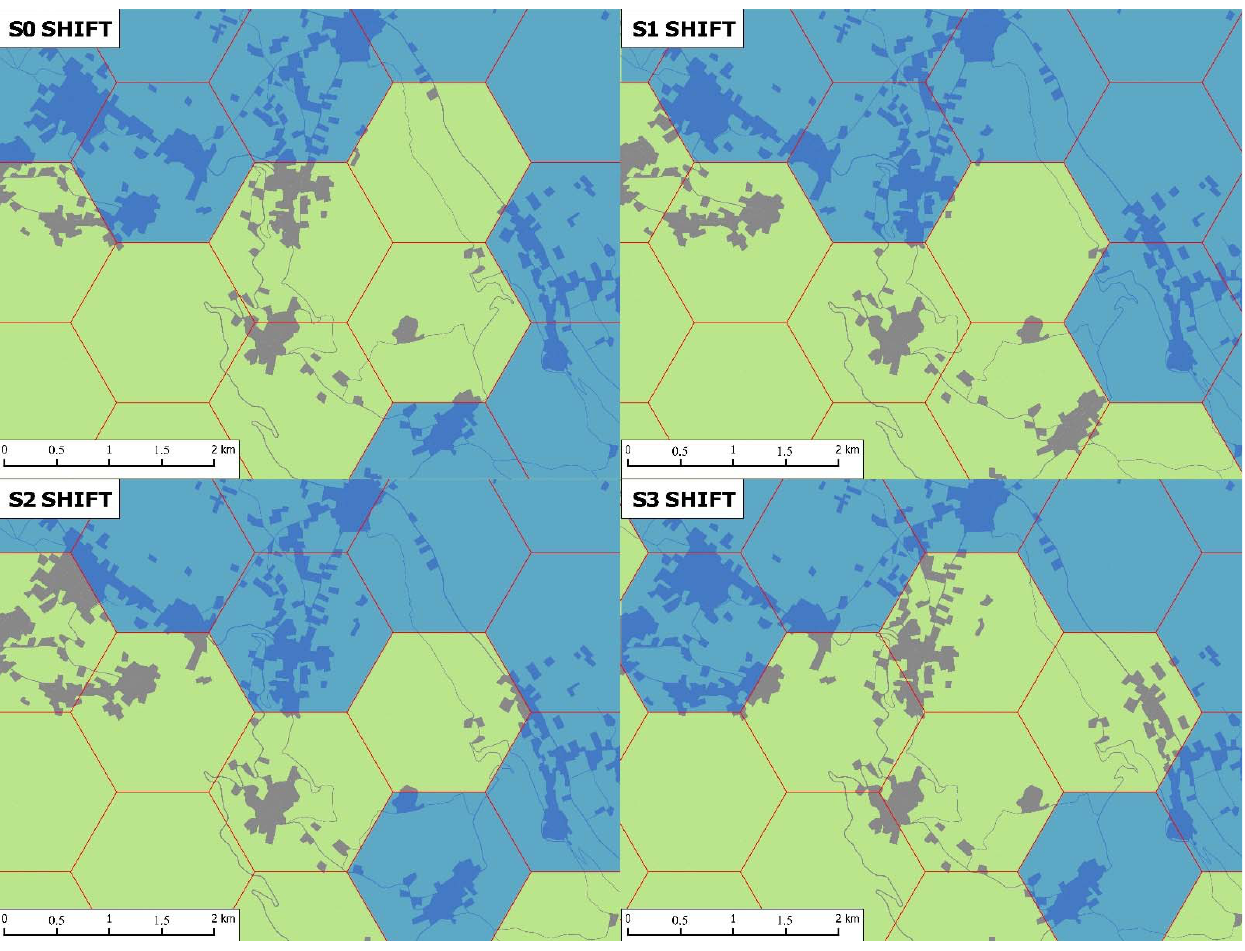
Figure 7. Cell recognition ability comparison.